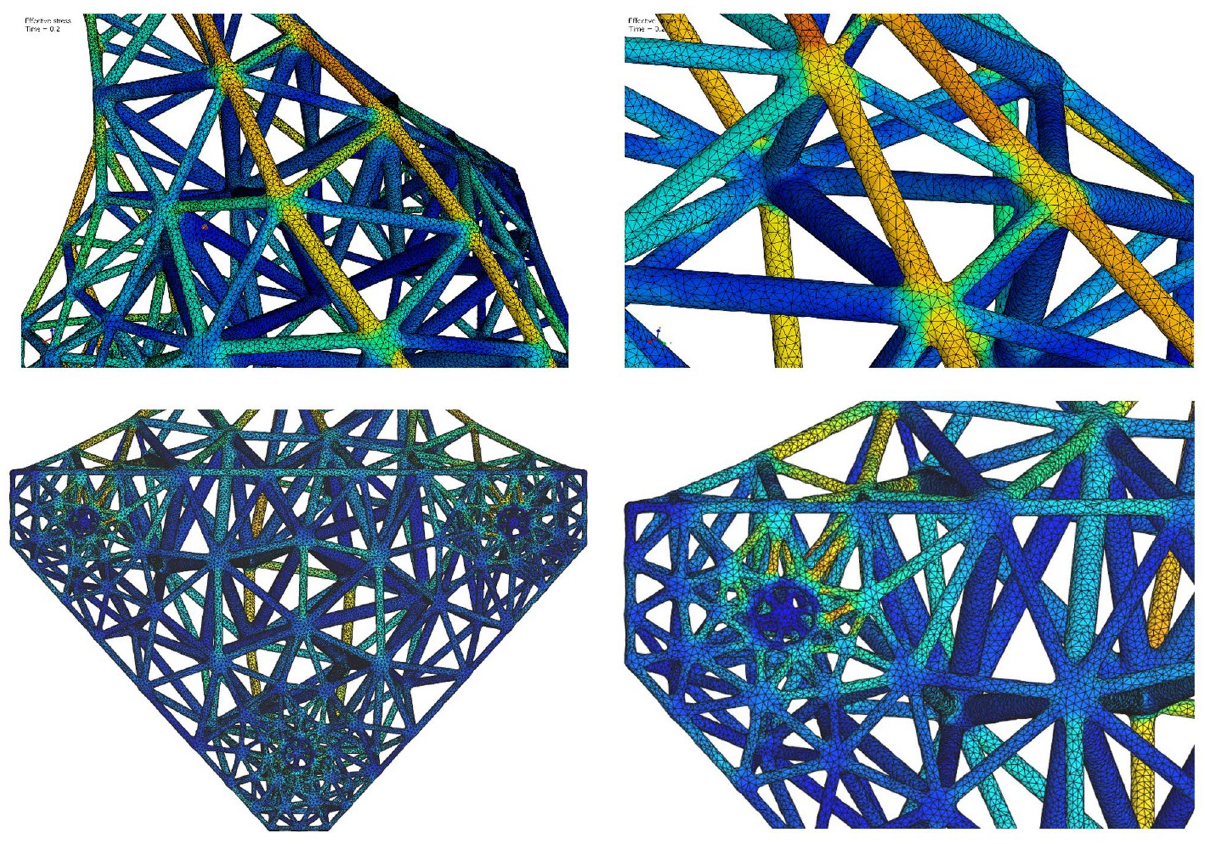
Figure 14. Four closer views showing detail of the lower-density HGon from Fig. 13B. Note the well-shaped tetrahedral elements with smooth topological transitions between the joint and strut structures. Initial computed von Mises stresses are also smooth, with no ‘jumps’ or concentrations that would indicate slivers or other undesirable FE mesh characteristics. The HGon accurately captures the multiple hole connectors, curved and straight edges, and other features of the original CAD